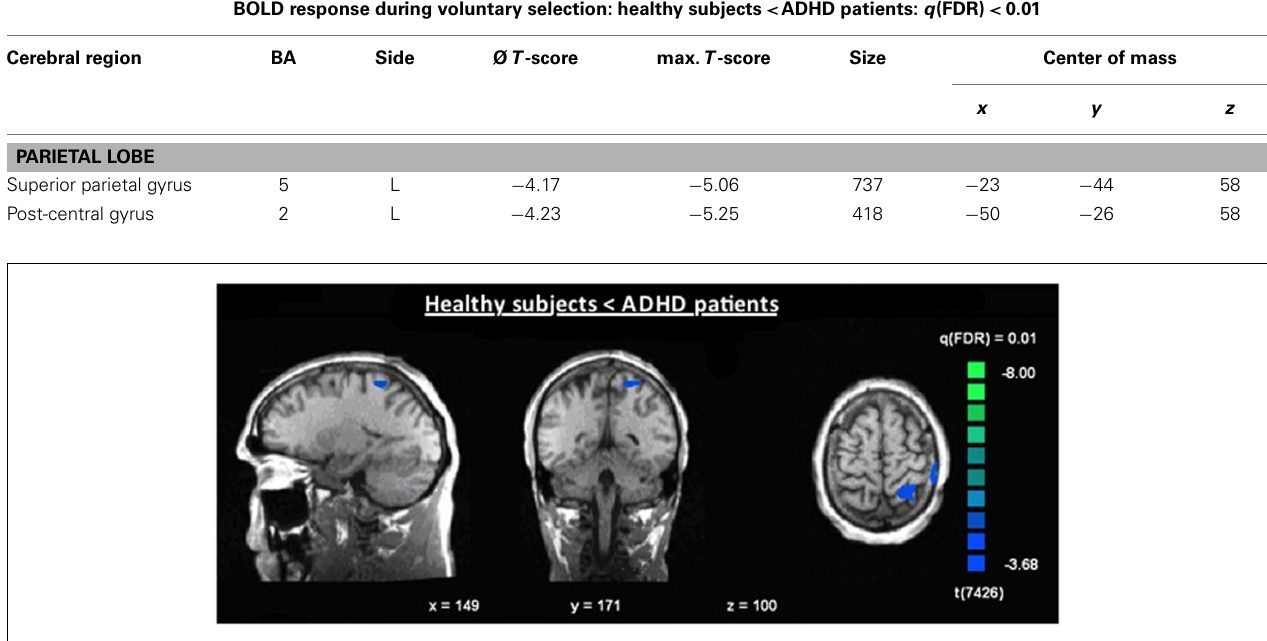
Table 4 | Single-trial analyses: N2-related BOLD activity; areas that showed less BOLD responses in healthy subjects compared toADHD patients during voluntary selection tasks [ q (FDR) < 0.01; T = 3.68–8; cluster size > 30Voxel].